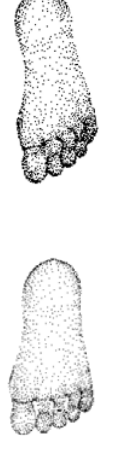
Fig. 13. Two-dimensional foot bottom.